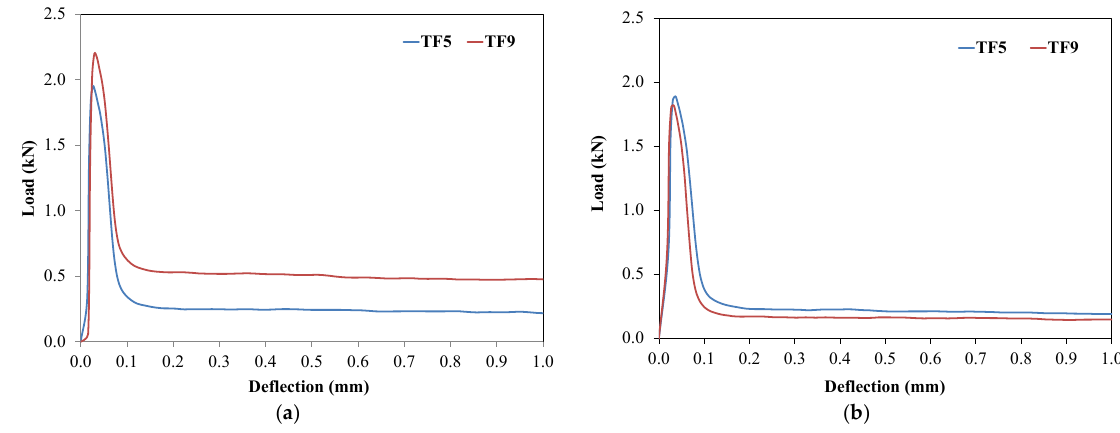
Figure 16. Load ‐ deflection behavior of twill (3/1) weave fabric ( a ) warp ( b ) weft. Figure 16. Load-deflection behavior of twill (3/1) weave fabric ( a ) warp ( b ) weft. Table 7. Tensile results of tested textile fabrics. Table 7. Tensile results of tested textile